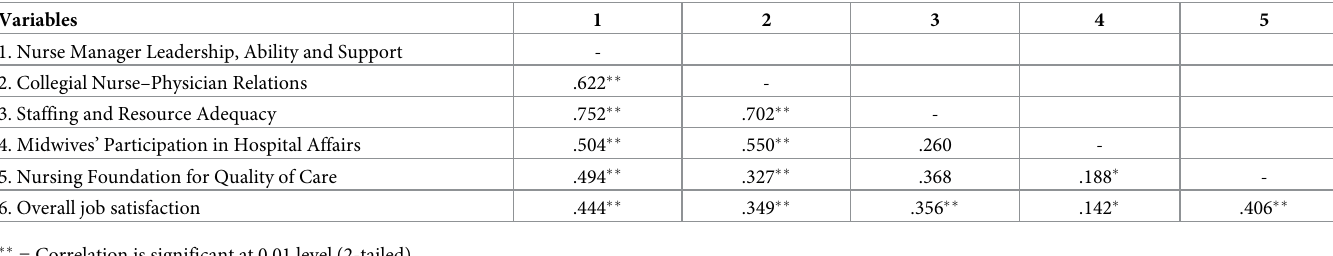
Table 3. Correlations between the practice environment dimension and overall job satisfaction.